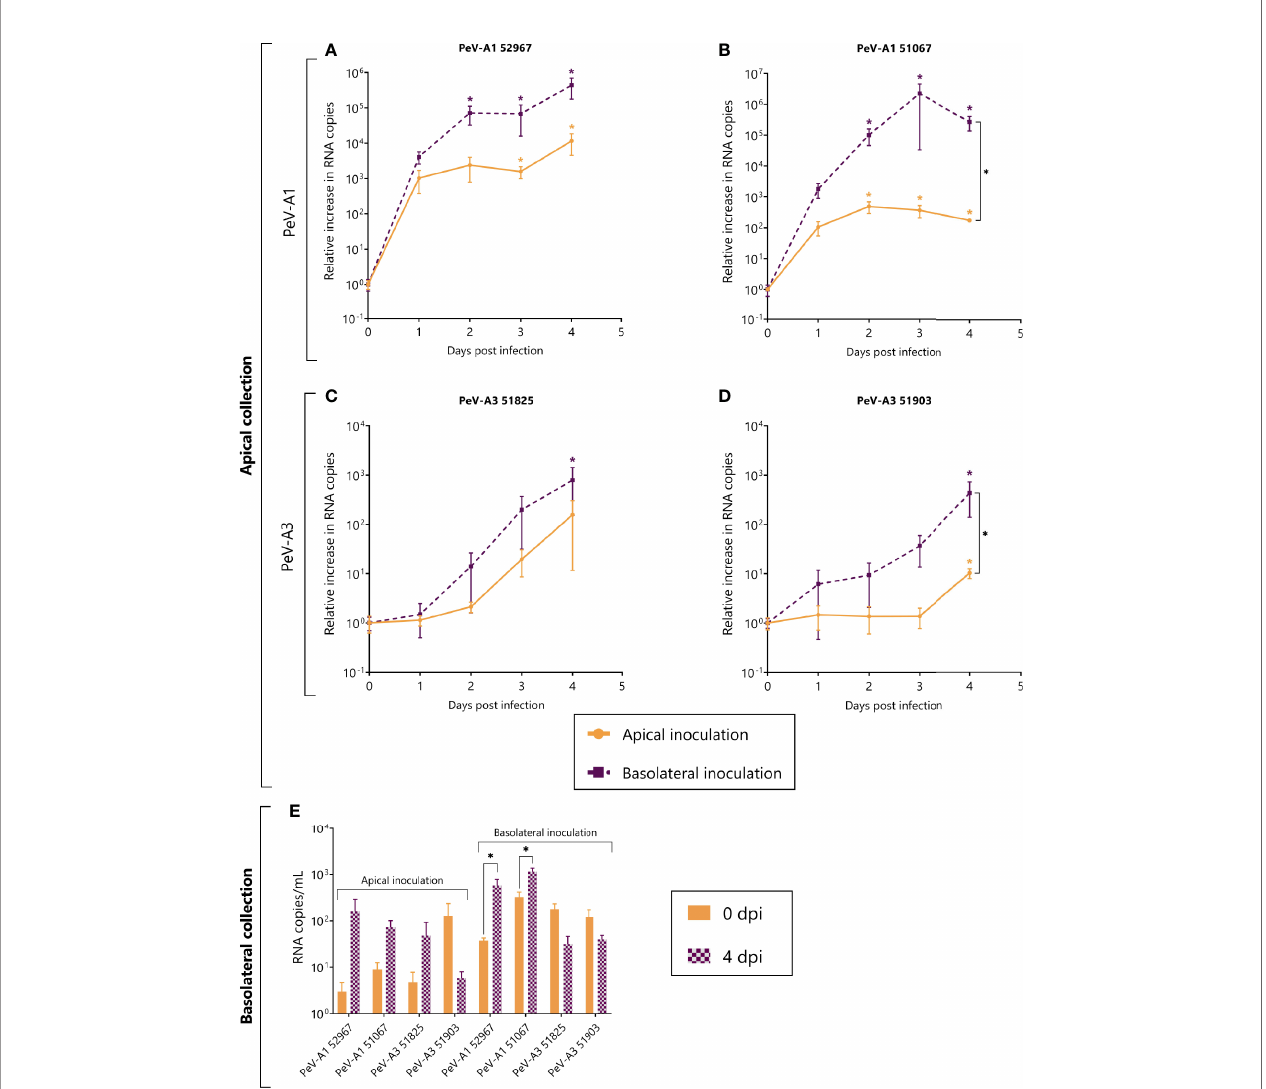
FIGURE 4 | Replication kinetics of clinical isolates of PeV-A1 and PeV-A3 in intestinal monolayers. (A – D) Represent the relative increase in RNA copies in samples collected from the apical compartment after both apical and basolateral inoculation; (A, B) are PeV-A1 clinical isolates from stool samples; (C, D) are PeV-A3 clinical isolates from stool samples. (E) Represents the total amount of viral copies at 0 dpi and 4 dpi in the basolateral compartment, after either apical or basolateral inoculation. In all cases, data represent the mean ± SEM of two technical replicates in three biological replicates. * p -value < 0.05. dpi = days post